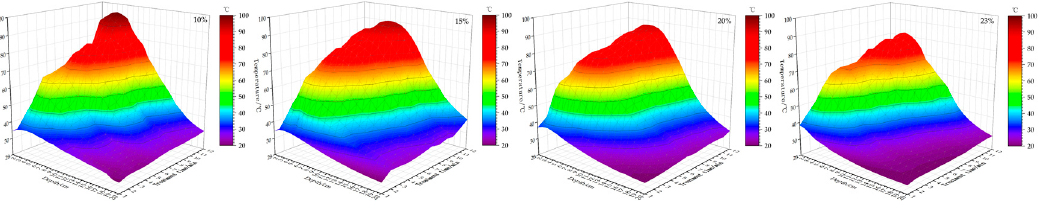
Figure 25. The division of the overall effective area of the microwave-irradiated soil model.